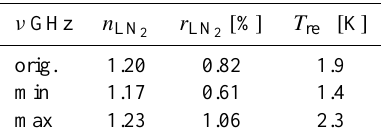
) and reflectivities ( r LN 2